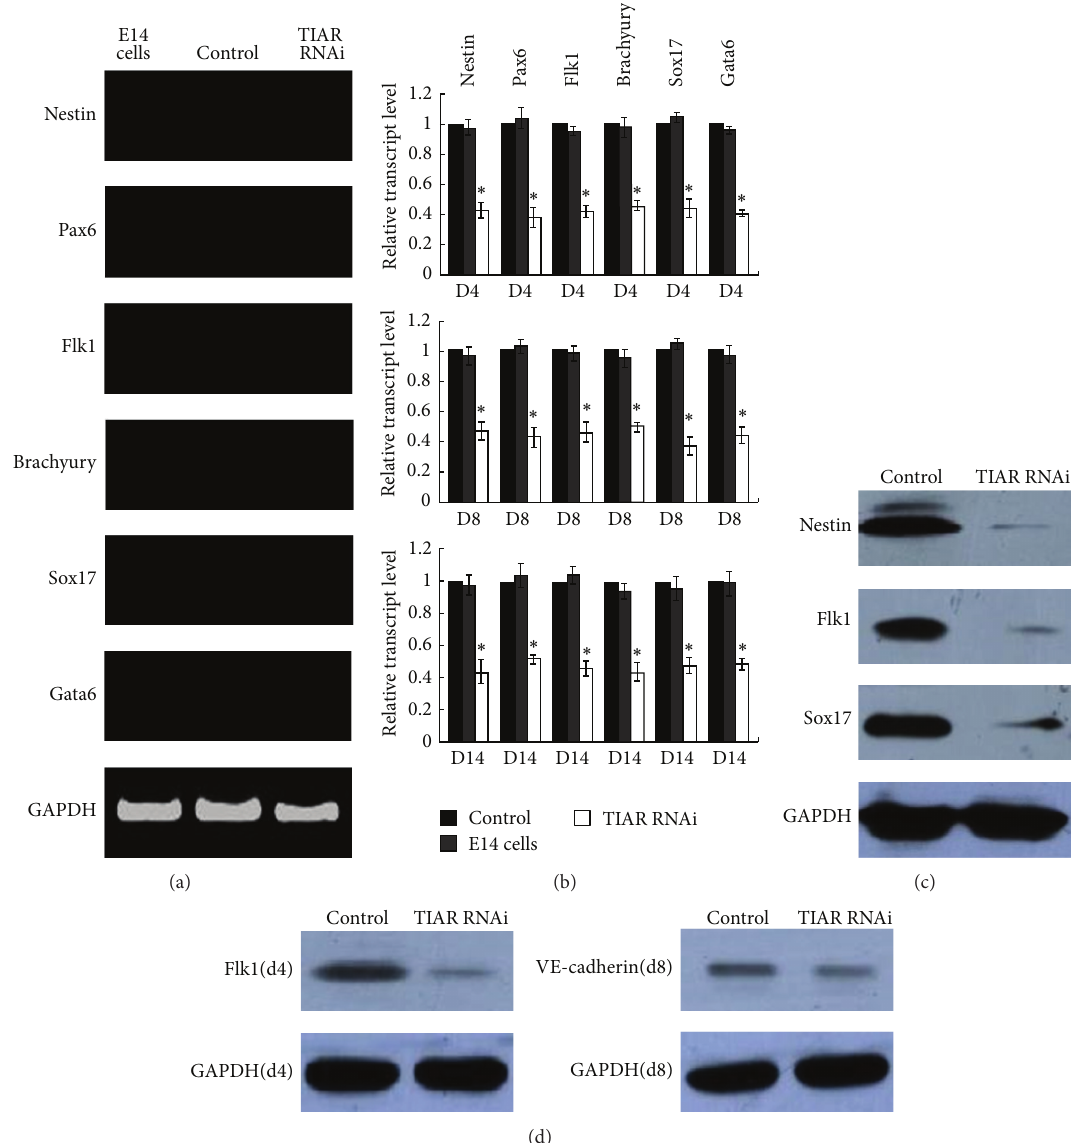
Figure 2: Downregulation of TIAR protein levels restrained the differentiation of E14 cells. (a) RT-PCR analysis of the gene expression of nestin, Pax6, Flk-1, brachyury, Sox17, and Gata6 on day 0 in TIAR RNAi E14 cells and pSIREN-RetroQ control E14 cells. E14 cells were used as control. (b) Quantitative RT-PCR analysis of the gene expression of nestin, Pax6, Flk-1, brachyury, Sox17, and Gata6 on day 4, day 8, and day 14 during EB differentiation in TIAR RNAi E14 cells and pSIREN-RetroQ control E14 cells. Day 4, day 8, and day 14 EB differentiation of E14 cells were used as control. (c) Western blot analysis of the gene expression of nestin, Flk-1, and Sox17 on day 4 during EB differentiation in TIAR RNAi E14 cells and pSIREN-RetroQ control E14 cells. (d) Western blot analysis of the gene expression of Flk-1 (day 4) and VE-cadherin (day 8) in monolayer differentiation of TIAR RNAi E14 cells and pSIREN-RetroQ control E14 cells. ∗ 𝑃 < 0.05 by one-way ANOVA. Control: pSIREN-RetroQ control E14 cells; TIAR RNAi: TIAR RNAi E14 cells.